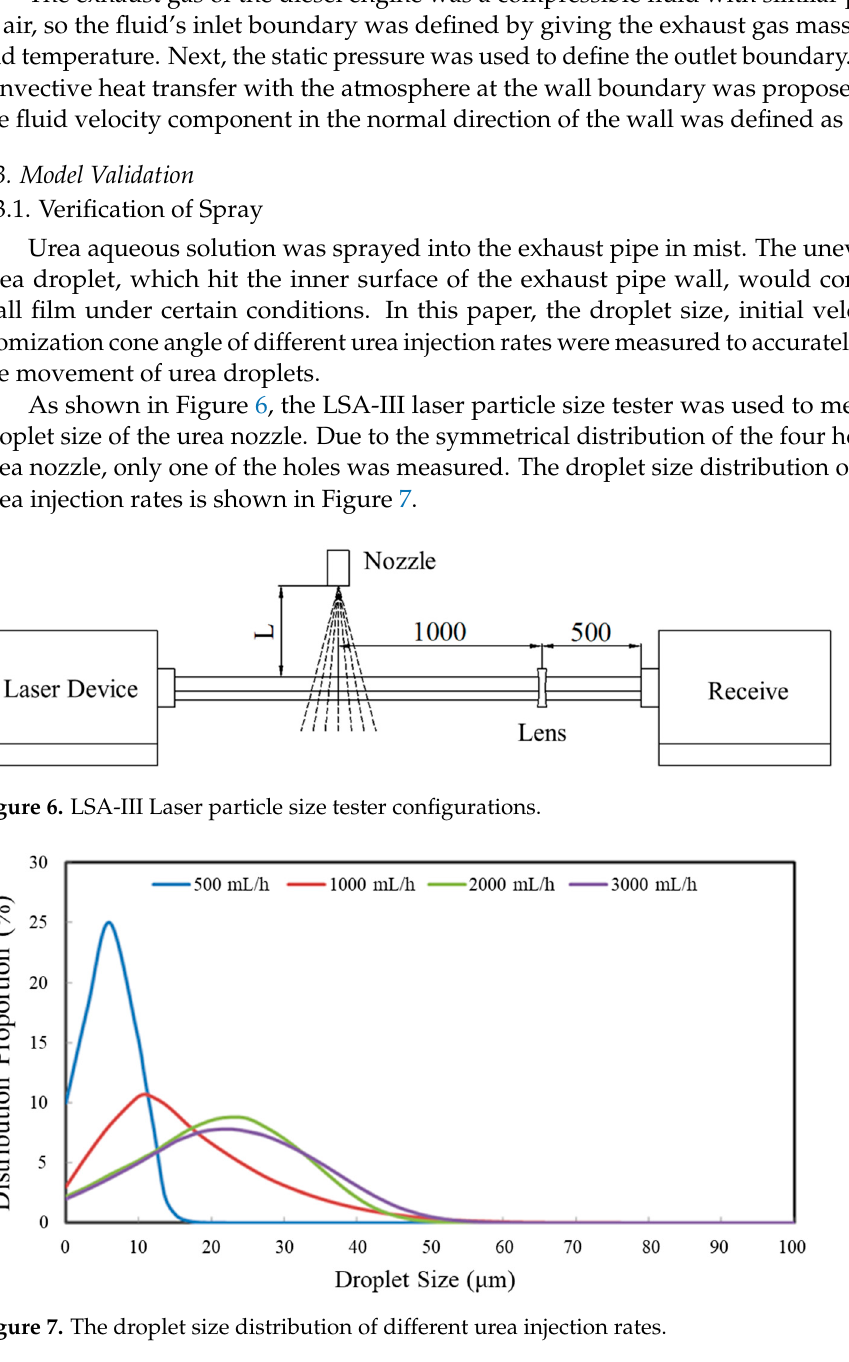
Figure 8. Diagram of high-speed photography test. Table 3. The droplet initial velocity and atomization cone angle of di ff erent urea injection rates. Injection Rate